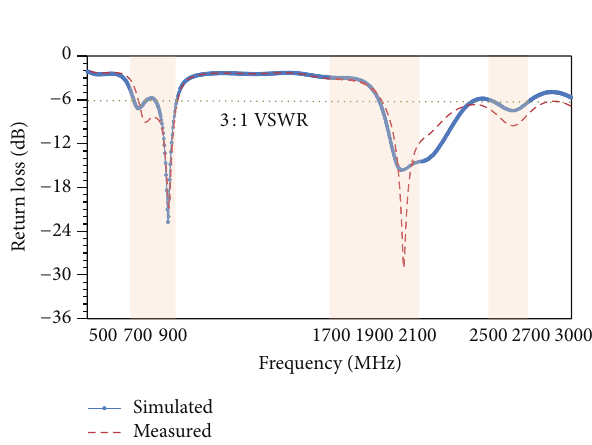
Figure 5: Simulated and measured VSWR of the proposed antenna at V 2 port.